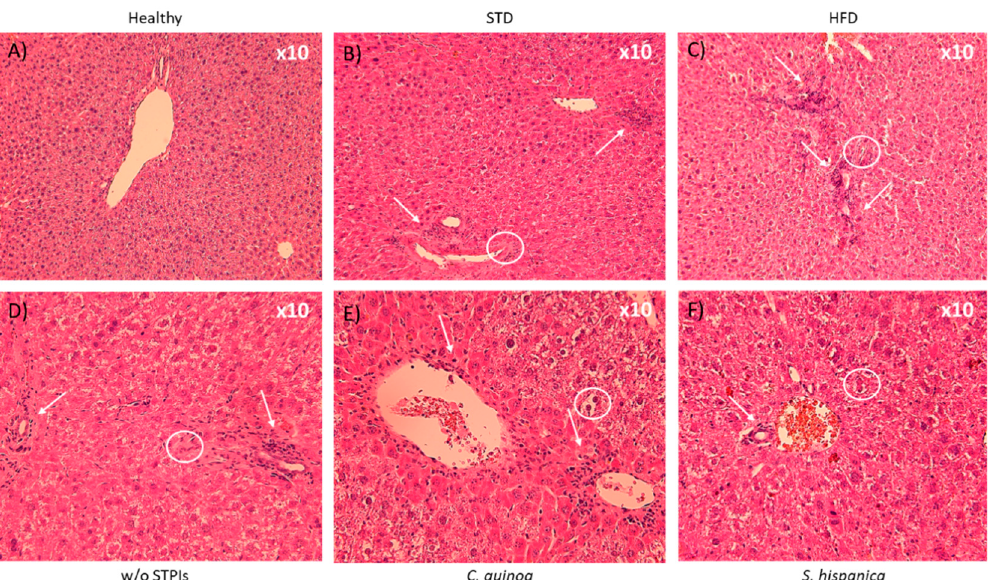
Figure 2. Liver hematoxylin and eosin staining of 14 weeks-old high fat diet-fed C57BL/6 mice administered with or without PIs (100 µg/animal) ( A,B ). At the end of the study period in the w/o STPIs group, 4 animals were analyzed, while in those administered with C. quinoa and S. hispanica 6 animals were analyzed. Arrows indicate prominent accumulation of nodes of mononuclear cells after 14 weeks. Circles locate irregular contours of the bile duct with nuclear pseudostratification and vacuolization of the epithelium, with marked portal inflammation ( C , D ). ( E , F ) Artifice that produces steatosis suggestive image.